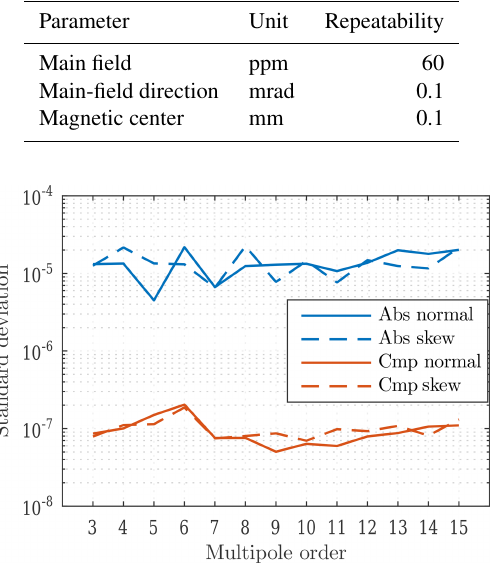
Figure 8. The measurement precision of field harmonics of a single position. Abs: absolute. Cmp: compensated.